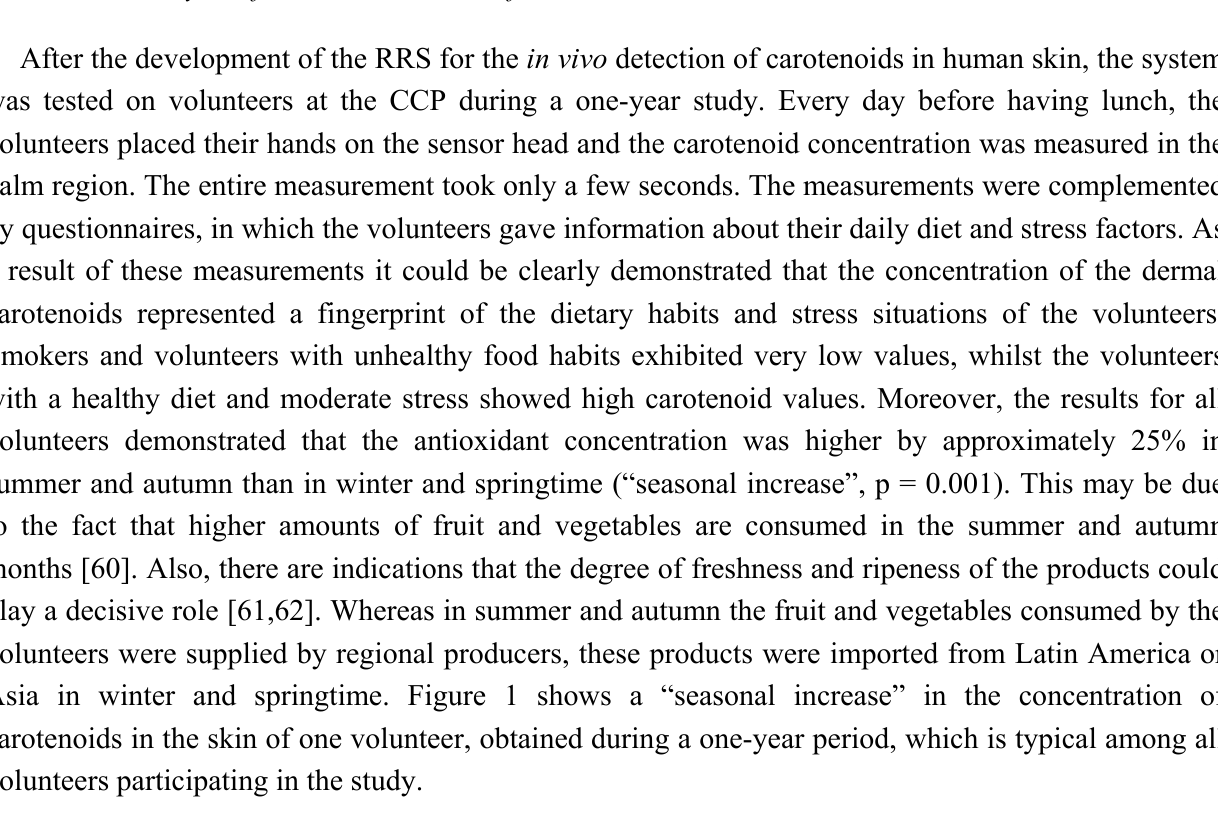
Figure 1. Average monthly values of the dermal carotenoid concentration for one volunteer during a one-year period measured on the inner